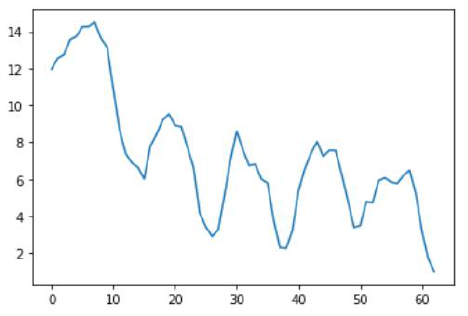
Figure 18. Magnetometer y -axis noise (CCIS/KSU).